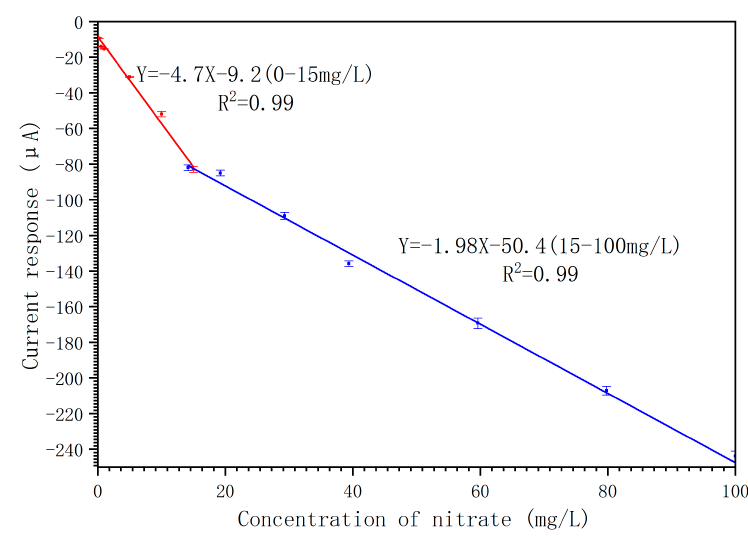
Figure 7. The response curve of the chips modified by Pd-AuNPs composite sensing film.